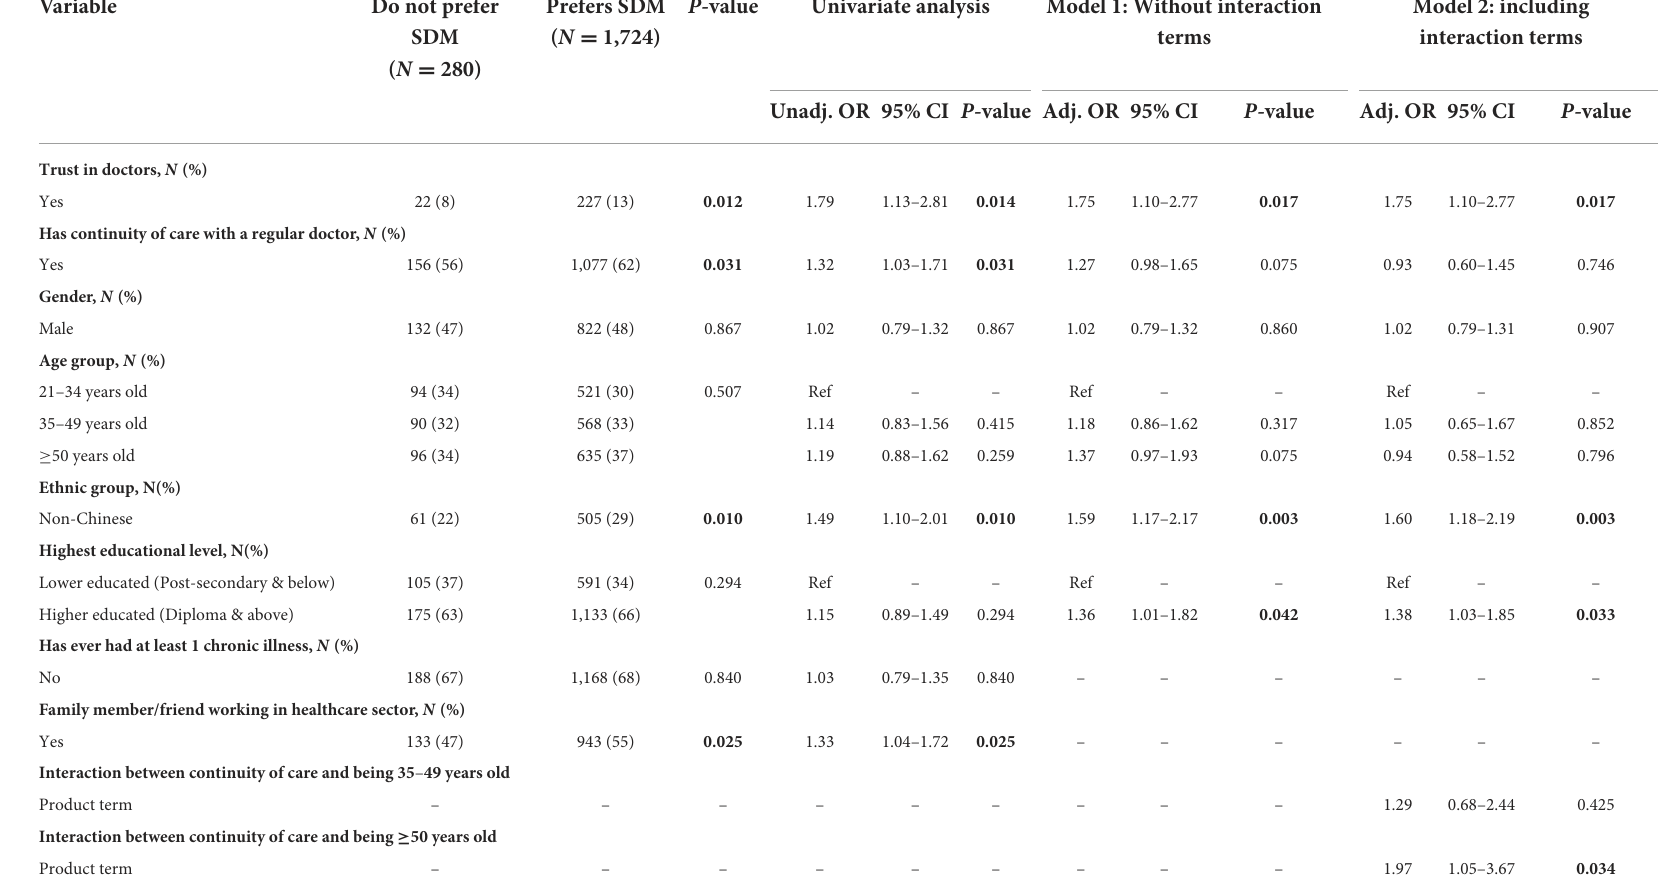
TABLE 2A Univariate and multivariable logistic regression examining factors associated with preference for shared decision-making on antibiotic prescribing, N = 2004.